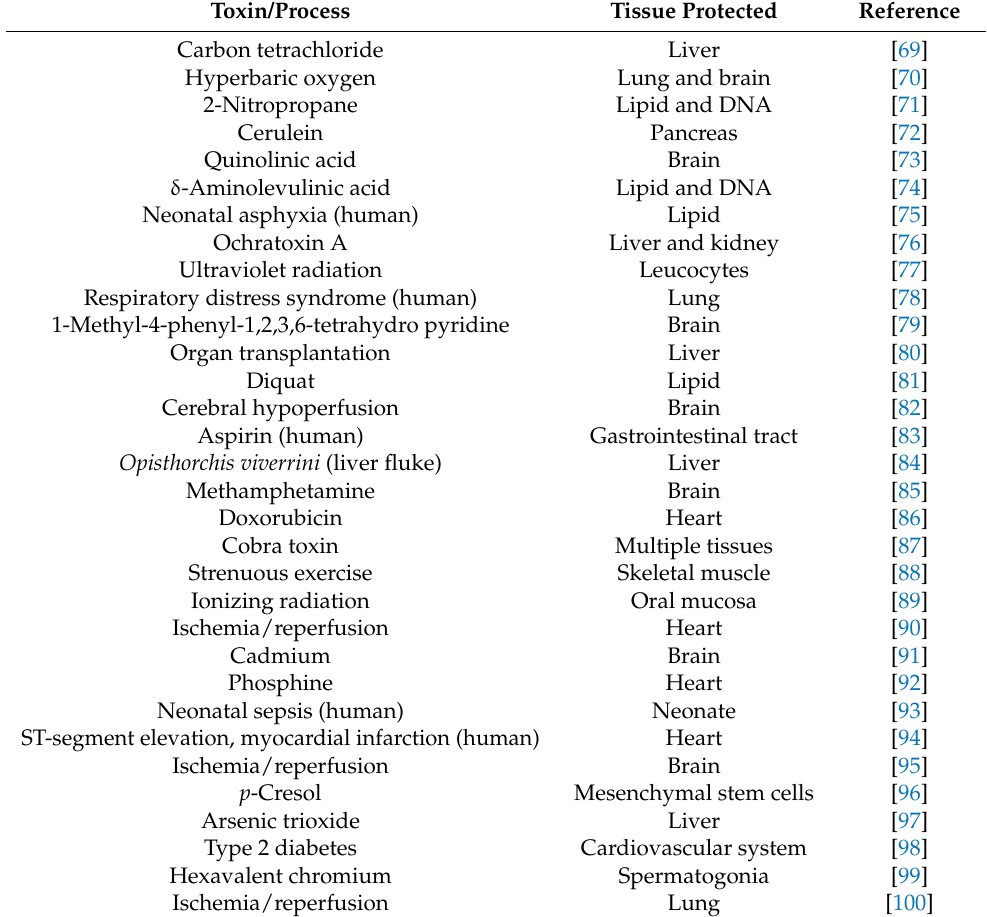
Table 1. Experimental evidence that melatonin reduces oxidative stress and related events in cells, animals, and humans. Listed here are representative publications where melatonin was used to diminish oxidative damage and/or associated physiological/molecular changes following exposure to a variety of different chemical toxins/processes that normally lead to oxidative mutilation of critical molecules, cellular apoptosis, and compromised organ function. As mentioned, these are representative reports; there are many more. If the reader has a specific interest in a toxin/melatonin interaction, it (they) could be easily found in an appropriate literature search. Also, for many of the subjects listed, there are numerous publications documenting the protective function of melatonin, e.g., in ischemia/reperfusion injury, heavy metal toxicity, etc. The reports are in chronological